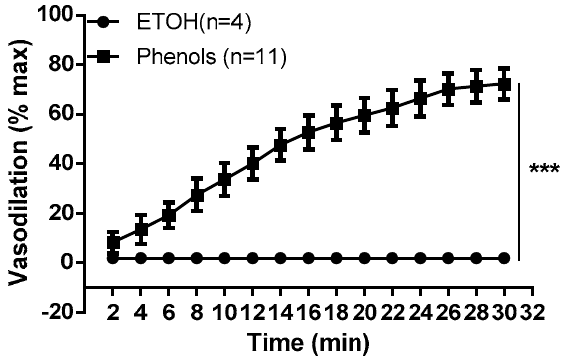
Molecules 2020 , 25 , x 3 of 10 Figure 2. Time course of vasodilation induced by extra virgin olive oil phenols. The figure shows the time course for phenols (3 × 10 − 5 M) from crude extra virgin olive oil (phenols) and for the phenol vehicle, ethanol (1‰ vehicle), tested on phenylephrine-contracted resistance mesenteric arteries isolated from rats. Data are reported as the mean ± SEM, n (experimental number). Statistical analysis was performed using two-way ANOVA, *** p < 0.001. To find out the molecular mechanism underlying the EVOO-phenol-induced vasodilation, phenols were tested in a single dose (3 × 10 − 5 M) on MA in different conditions. Data in Figure 3 show that removal of the endothelium (denuded artery), inhibition of nitric oxide synthase (NOS) by the inhibitors L -NAME and L -NNA, or inhibition of the cyclooxygenase (COX) by indomethacin did not affect the EVOO-phenol-induced vasodilation, which was similar to that in control vessels.